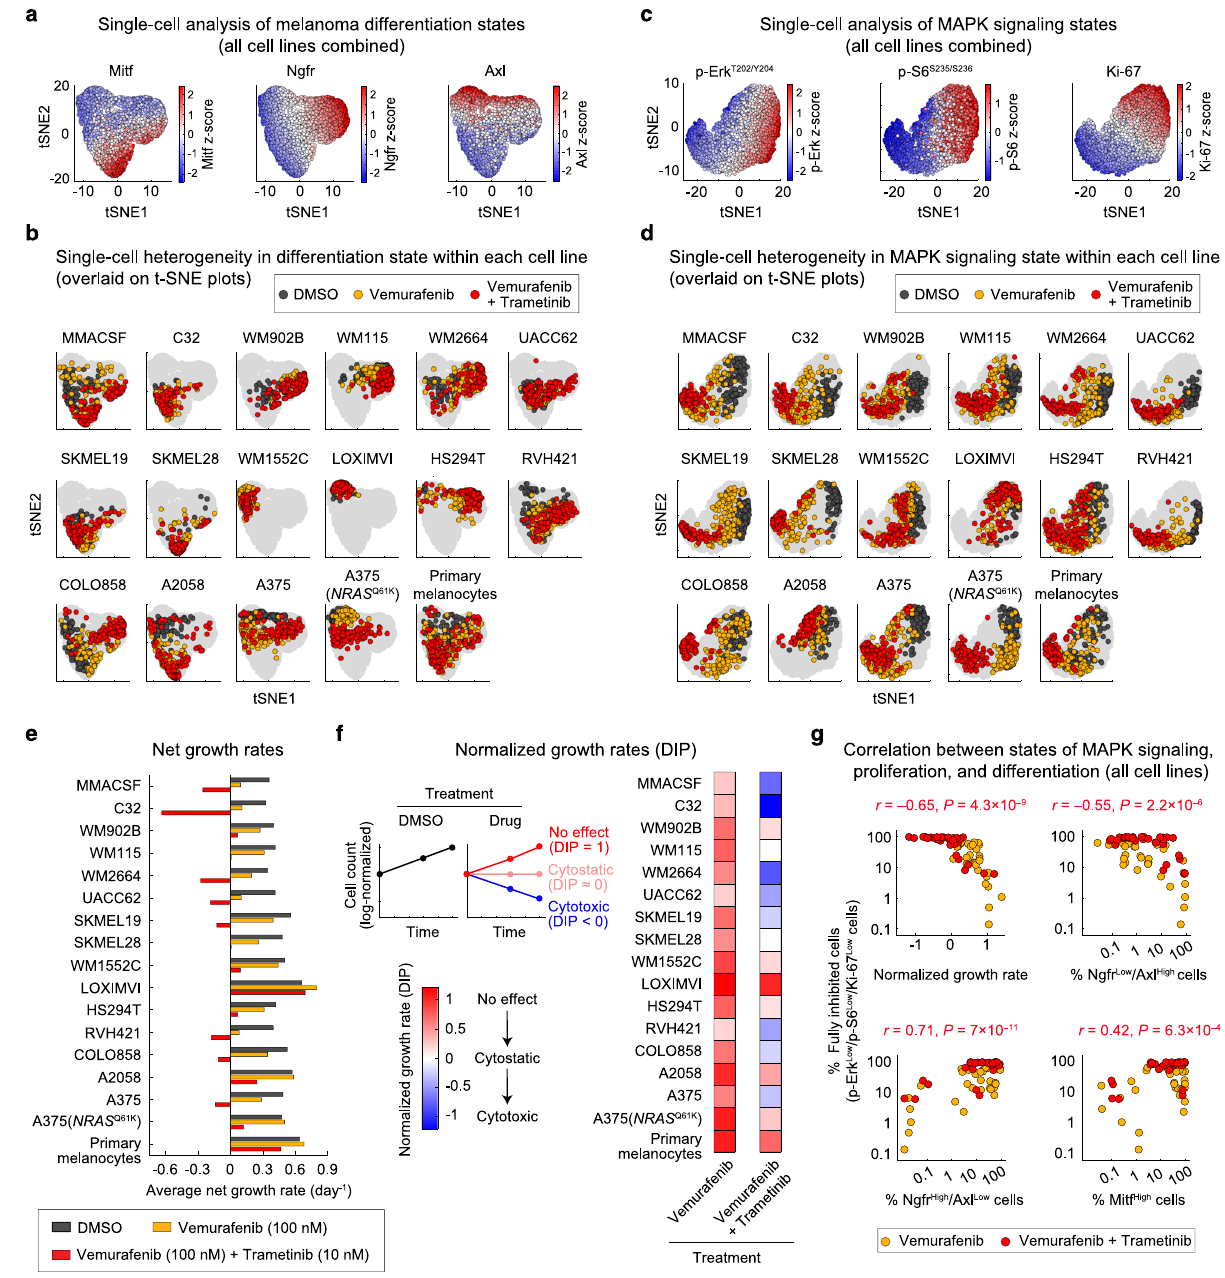
Fig. 1 Single-cell analysis uncovers heterogeneities in melanoma differentiation, proliferation, and MAPK signaling states across a wide range of Braf/ Mek inhibitor sensitivity. a , b Single-cell protein levels of three melanoma differentiation state markers, Mitf, Ngfr, and Axl, measured by multiplexed immuno fl uorescence microscopy and overlaid on t-SNE plots. Cells were exposed to either vehicle (DMSO), Braf inhibitor (vemurafenib at 100 nM), or the combination of Braf and Mek inhibitors (vemurafenib at 100 nM and trametinib at 10 nM) for 3 and 5 days. Cells for each experimental condition were randomly selected from the pool of two biologically independent replicates. Single-cell t-SNE maps for all cell lines combined ( a ) and projections of variation within each individual cell line ( b ) are shown. c , d Single-cell protein levels of p-Erk T202/Y204 , p-S6 S235/S236 , and Ki67, measured by multiplexed immuno fl uorescence microscopy and overlaid on t-SNE plots. Treatment conditions are the same as in ( a , b ). Single-cell t-SNE maps for all cell lines combined ( c ) and projections of variation within each individual cell line ( d ) are shown. e Average net growth rates calculated from measurements of live cell count (across at least two biologically independent replicates) at three timepoints (including 0, 3, and 5 days) following exposure to DMSO, vemurafenib (at 100 nM) or vemurafenib (at 100 nM) plus trametinib (at 10 nM). f Drug-induced normalized growth rates (a.k.a. DIP rates) calculated by dividing the average net growth rate for drug-treated cells to that for DMSO-treated cells in each cell line. Normalized growth rates <0 indicate a net cell loss (i.e., drug-induced cytotoxicity), a value of 0 represent no change in viable cell number (i.e., cytostasis), a value >0 indicates a net cell gain, and a value of 1 represents no drug effect as cells grow at the same rate as in the DMSO condition. g Two-sided Pearson ’ s correlation analysis between the fraction of p-Erk Low /p-S6 Low /Ki67 Low cells (referred to as fully inhibited cells) and drug-induced normalized growth rate (top left), the fraction of undifferentiated (Ngfr Low /Axl High ) cells (top right), the fraction of neural crest-like (Ngfr High /Axl Low ) cells (bottom left), and the fraction of melanocytic (Mitf High ) cells (bottom right) across 16 melanoma cell lines treated with Braf/Mek inhibitors for 3 and 5 days. Source data are provided as a Source data fi le.